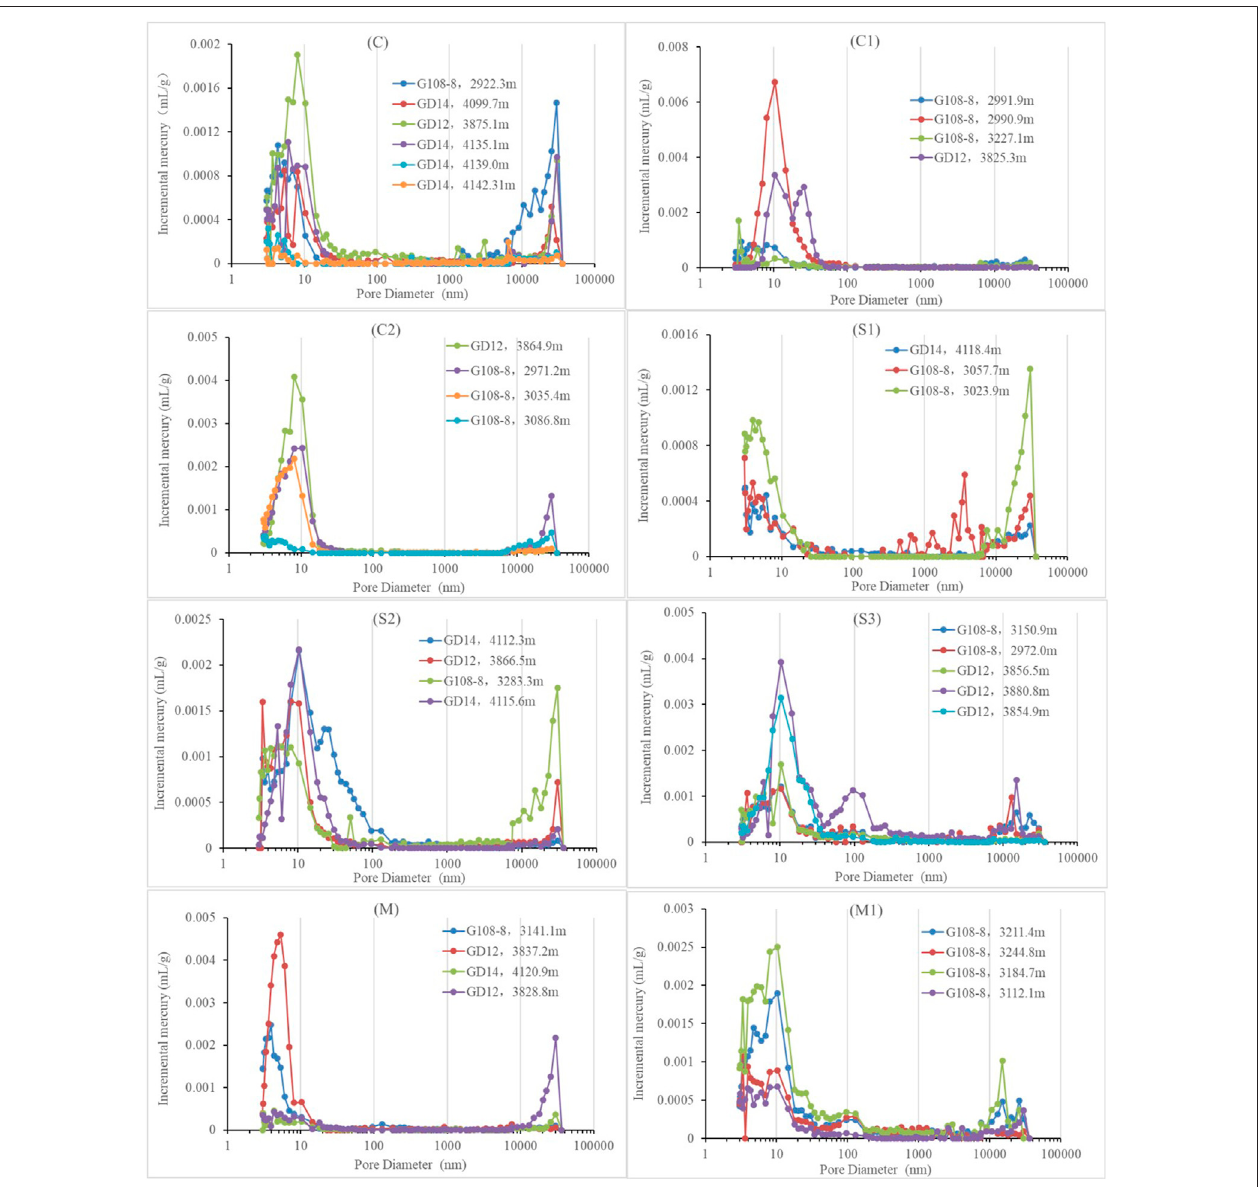
FIGURE 6 | Distributions of pore-throat diameter of different lithofacies. C: Low organic matter (OM) — massive — carbonate shales. C1: Medium to high OM — laminated — siliceous carbonate shales. C2: Low to medium OM — layered — mixed carbonate shales. S1: Medium to high OM — laminated — carbonate siliceous shales.S2:MediumtohighOM — massive — mixedsiliceousshales.S3:MediumtohighOM — laminated — argillaceoussiliceousshale.M:LowtomediumOM — massive -mixed shale. M1: Medium to high OM — laminated — mixed shale.